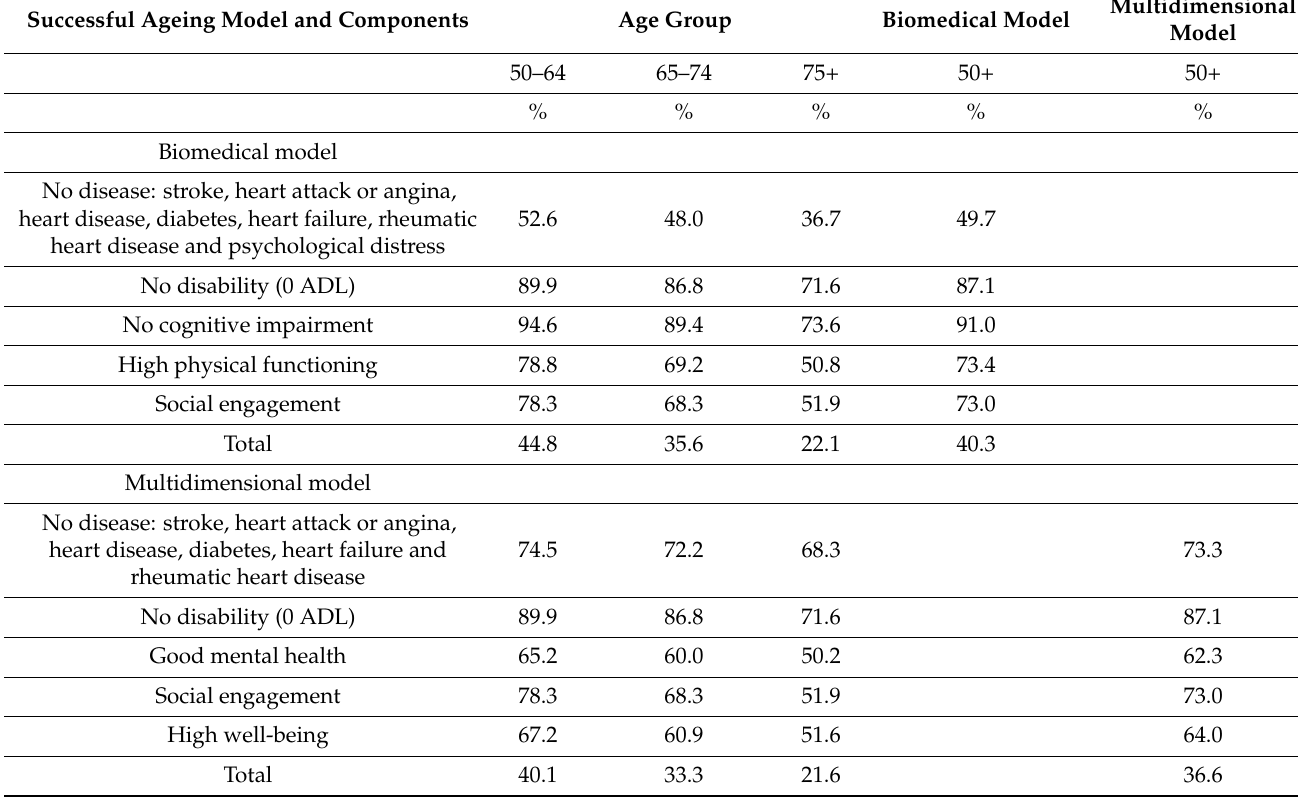
Table 2. Healthy ageing by biomedical and multidimensional